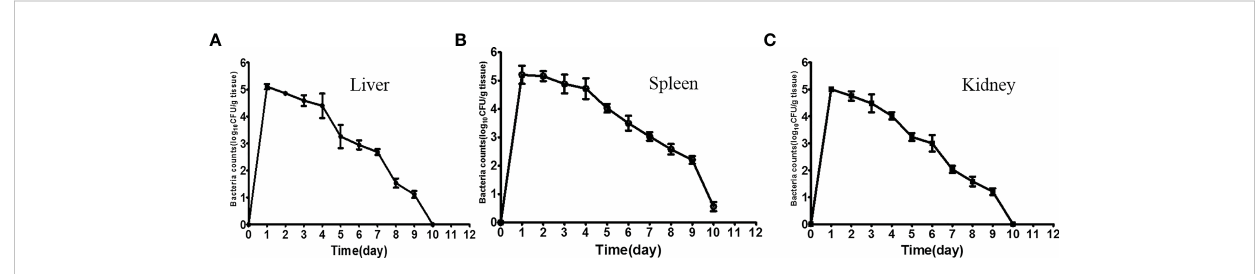
FIGURE 4 Dynamic distribution of fl iR Mutant strain. Bacterial loads in the liver (A) , spleen (B) , and kidney (C) of experimental fi sh 12 h after intraperitoneal